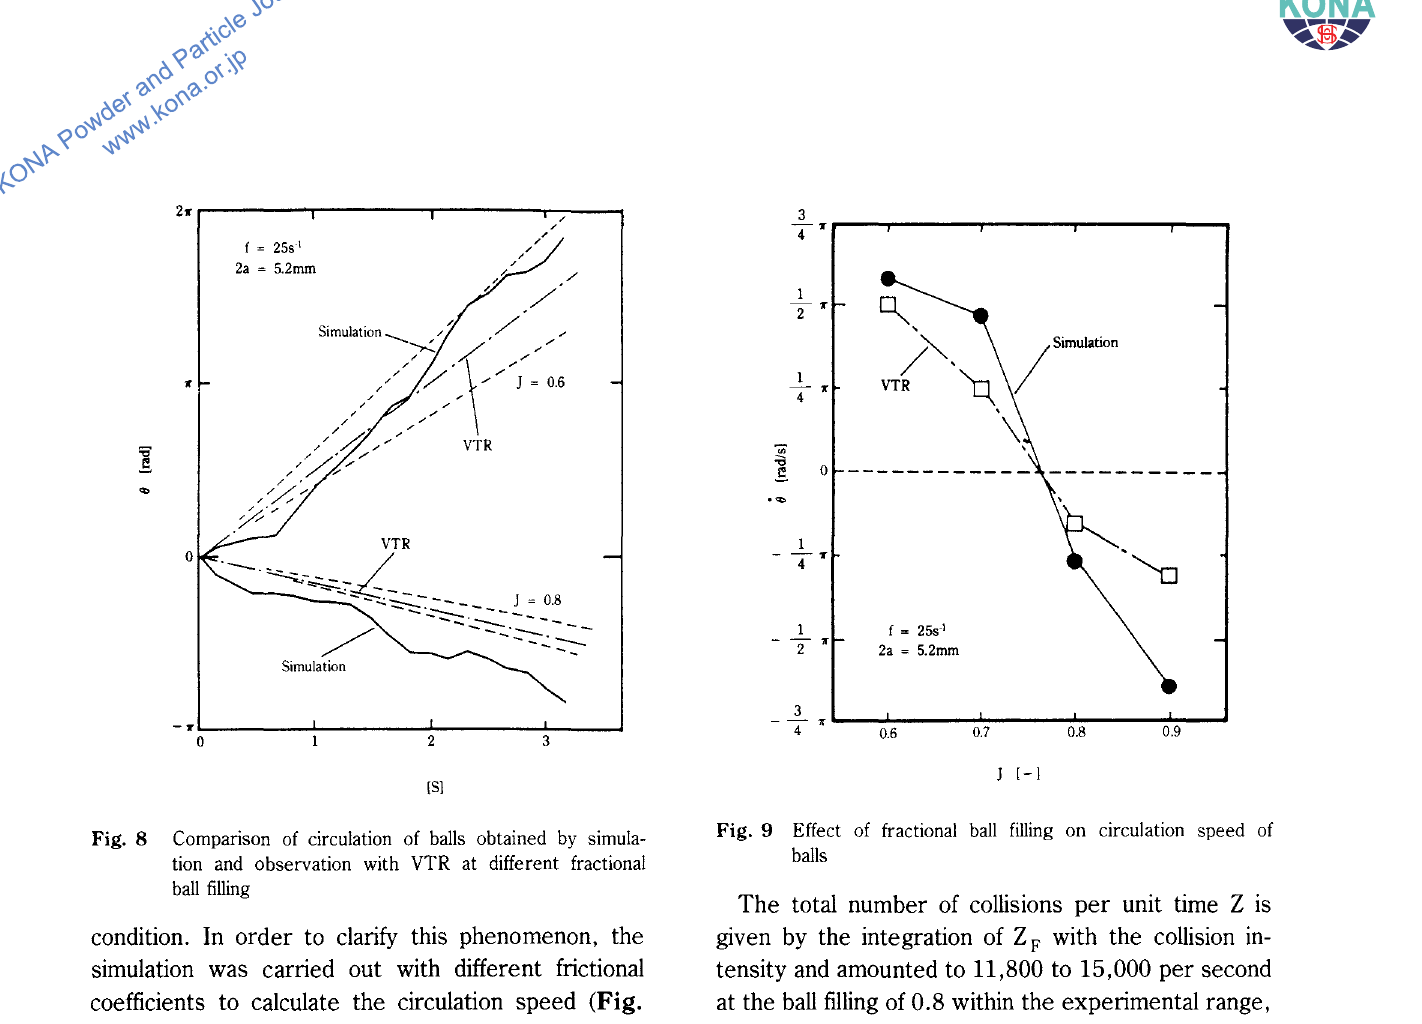
Fig. 9 Effect of fractional ball filling on circulation speed of